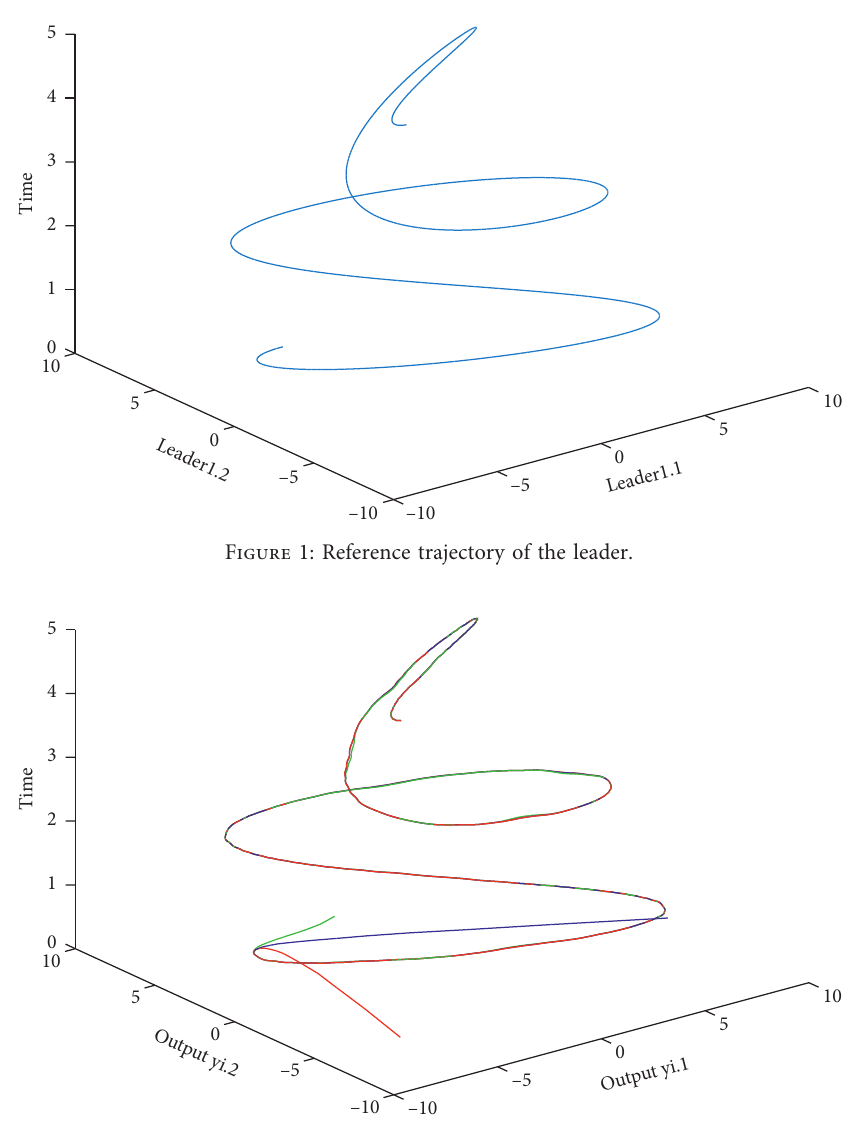
Figure 2: Consensus performance of three states following the